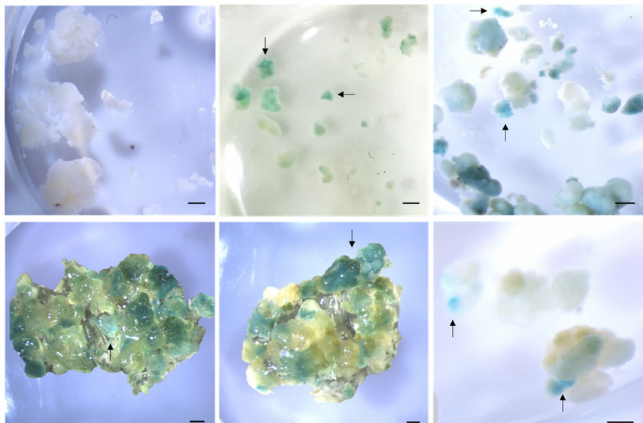
Figure 4. GUS assay in Agrobacterium -mediated genetic transformation of tamarillo embryogenic callus (EC). The negative control is non-transformed EC (first image). Arrows indicate indigo-blue coloration from GUS expression. Bars represent 1 mm.